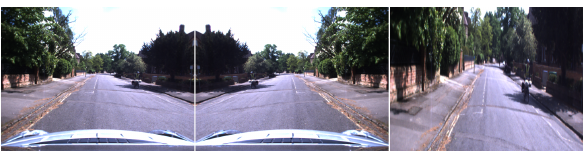
Figure 5: Original image of the RobotCar training set (left), after the flipping procedure (middle) and after cropping